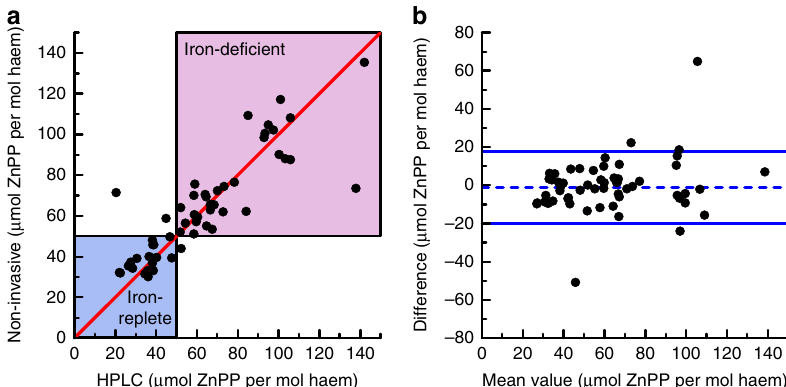
Figure 4 | Comparison of the non-invasive measurements with the reference HPLC method in the clinical study of 56 women after childbirth. ( a ) Comparison of the scaled non-invasive measurements in vivo with reference HPLC measurements in vitro . The blue area indicates values for subjects who are iron-replete (red blood cell ZnPP o 40 m molper mol haem) or in an indeterminate zone (red blood cell ZnPP 40–50 m molper mol haem, in which elevations do not necessarily indicate iron deficiency but may result from recent infection, inflammation or other factors). The red-shaded area indicates those who are functionally iron-deficient (red blood cell ZnPP 4 50 m molper mol haem). The line of identity is shown by the diagonal line in red. ( b ) Bland–Altman plot of the data presented in a . The blue lines indicate the robust limits of agreement (equalling 1.96 times the robust s.d.). The bias is indicated by the dashed blue line. Details for the two outliers are provided in the Supplementary Note 2.